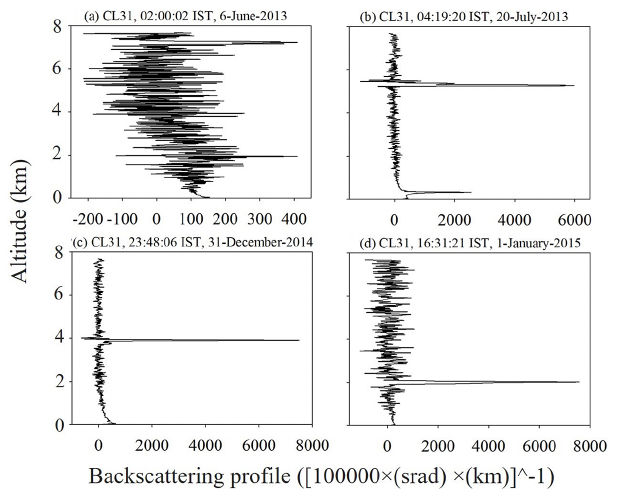
Figure 2. Vertical profile of backscatter data for different days (a) 6 June 2013 at 02:00:02IST, (b) 20 July 2013 at 04:19:20IST, (c) 31 December 2014 at 23:48:06IST, and (d) 1 January 2015 at 16:32:21IST from Ceilometer CL31 over Ahmedabad, India.